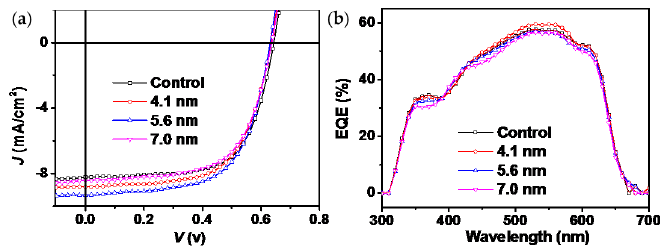
Figure 5. ( a ) Density-voltage ( J - V ) and ( b ) external quantum efficiency (EQE) curves of PSCs without and with PSBMA ETLs. The thickness of PSBMA varied as 4.1, 5.6, and 7.0 nm. Table 1. Detailed parameters of PSC devices with/without PSBMA ETLs.